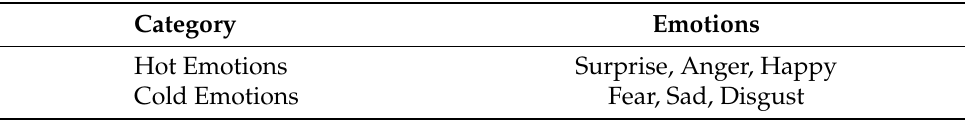
Table 1. Mapping of six basic emotions to hot and cold